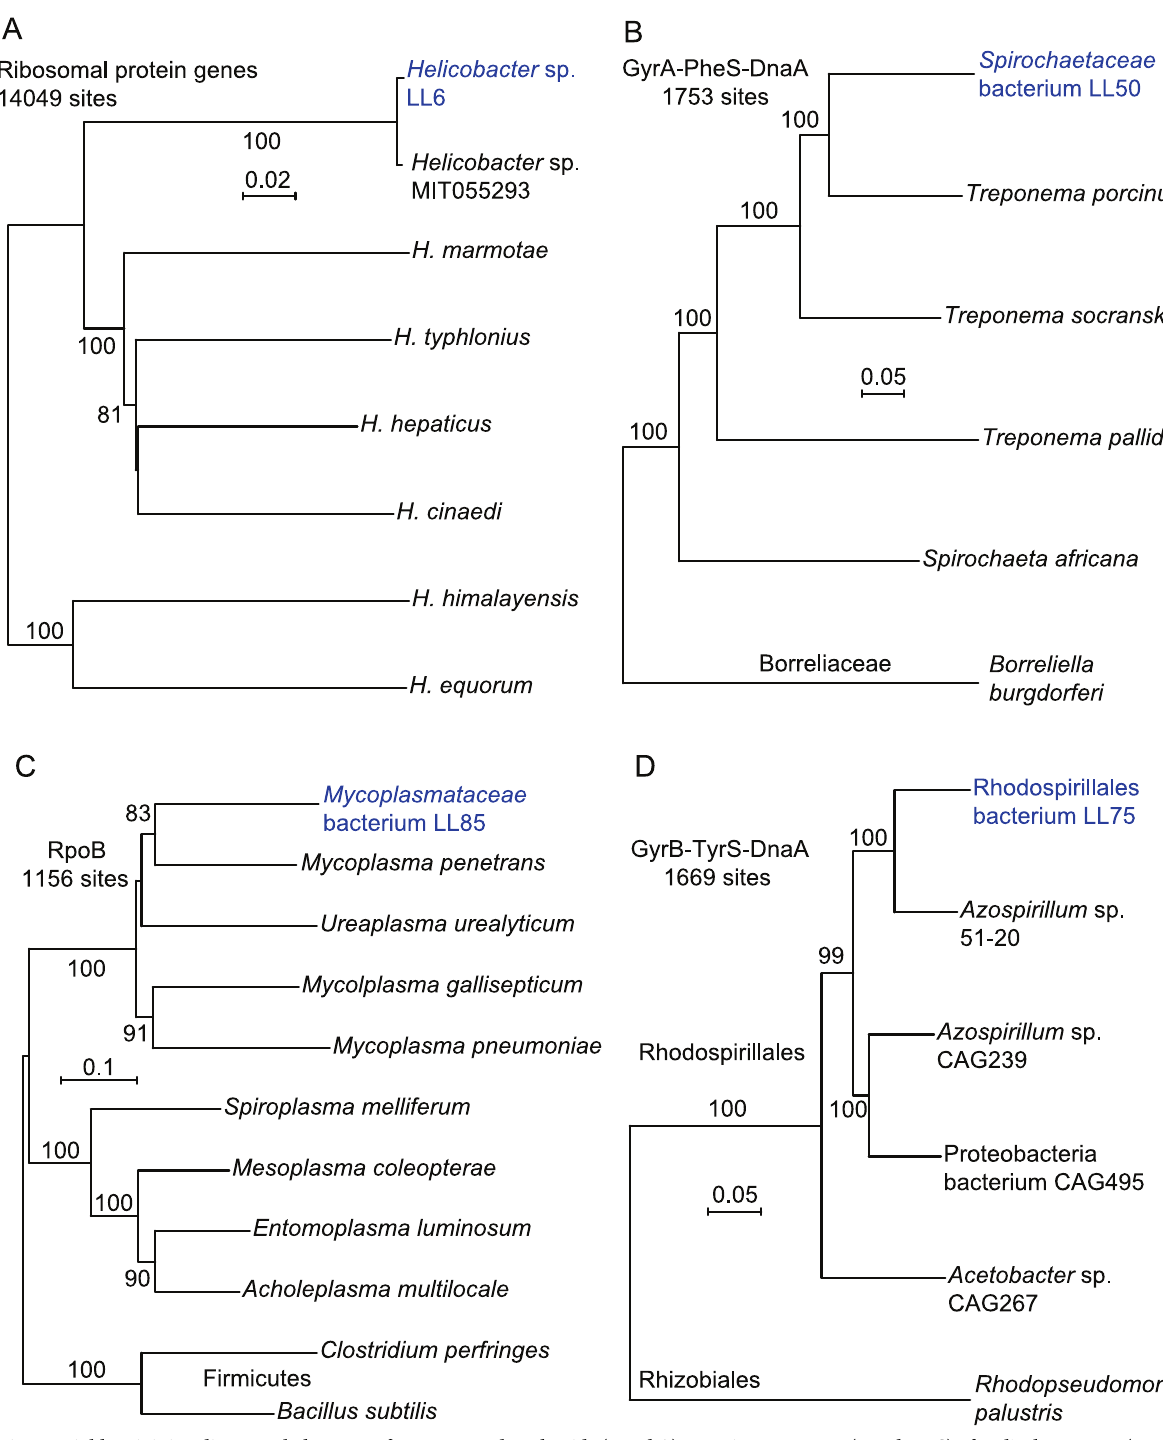
PLOS ONE | https://doi.org/10.1371/journal.pone.0231801 August 20,